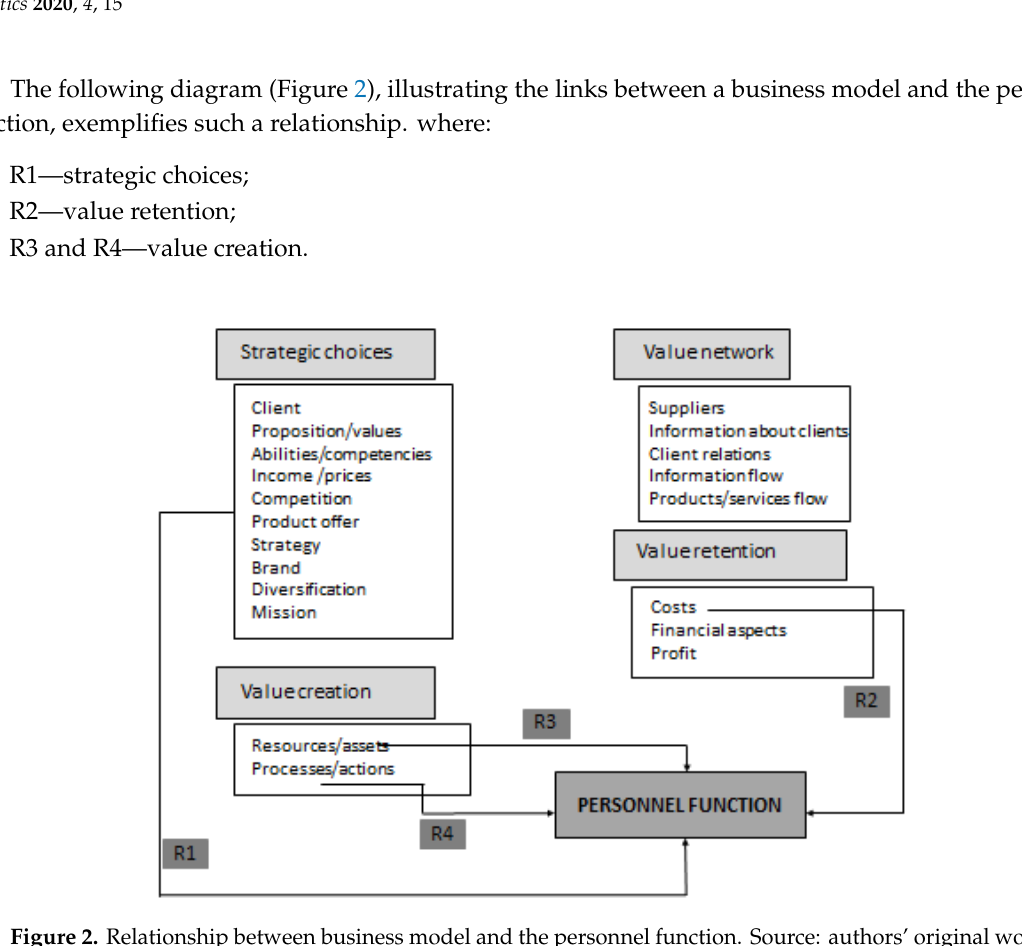
Figure 2. Relationship between business model and the personnel function. Source: authors’ original work.